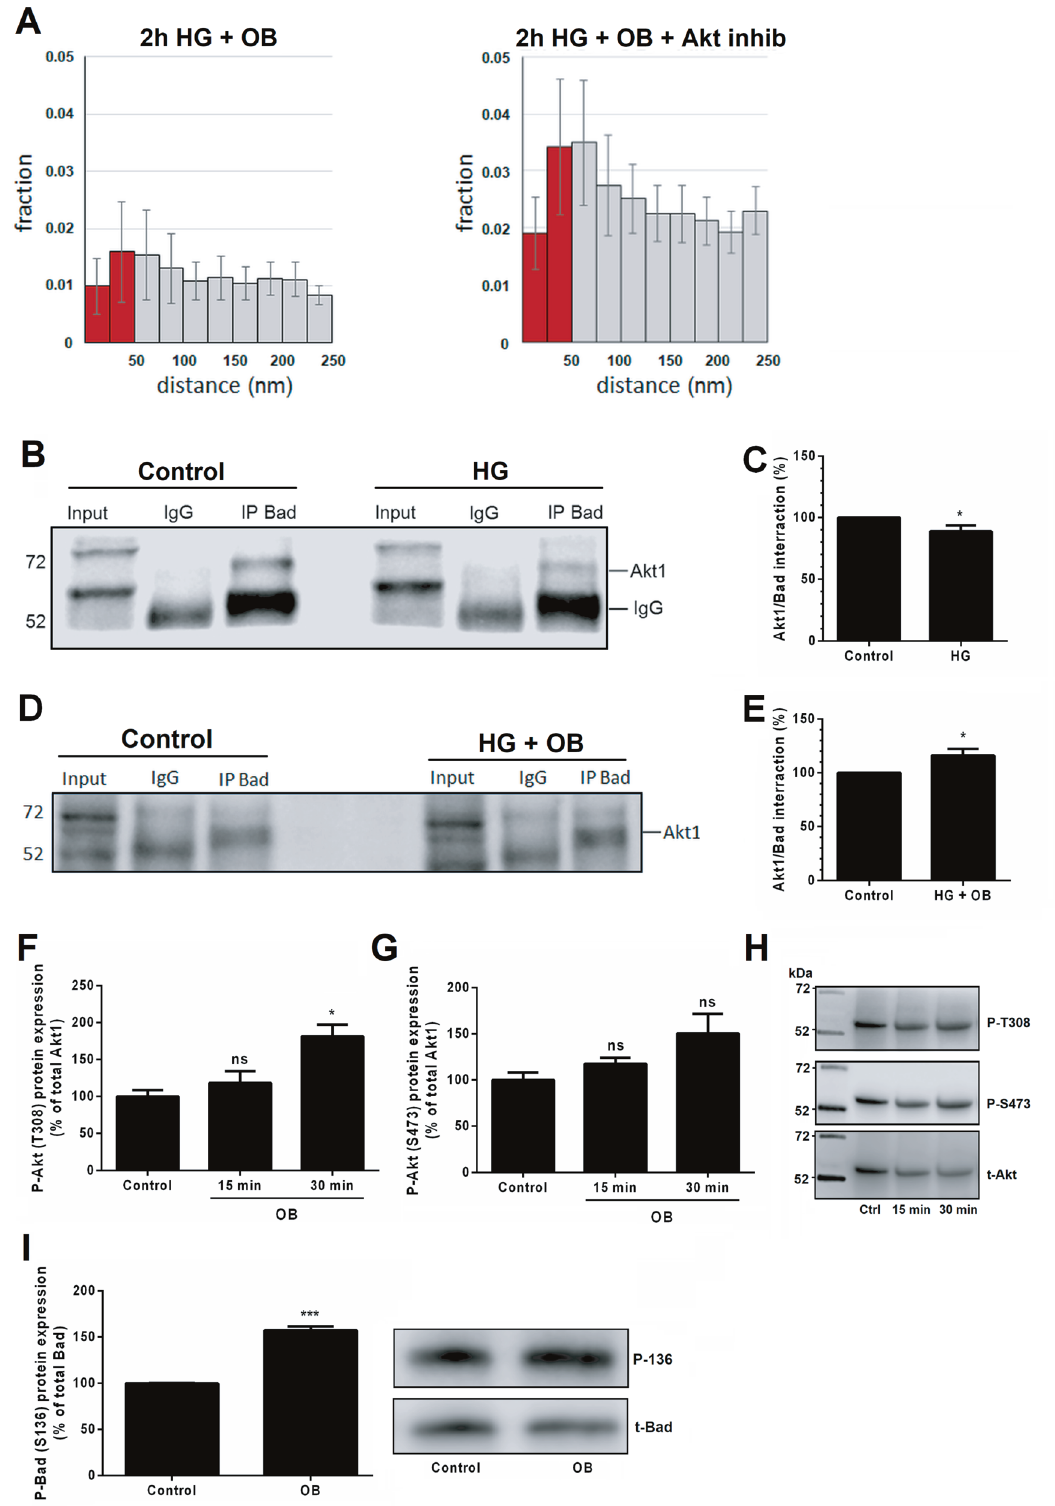
and 35%, respectively (Fig. 7A, B). The cells were treated with or without HG and ouabain for 6 h and the degree of apoptosis was estimated using TUNEL assay (for micrographs see Supplemental Fig. 2B). HG treatment signi fi cantly increased the apoptotic index in both control and siRNA-treated cells. Ouabain (10 nM)